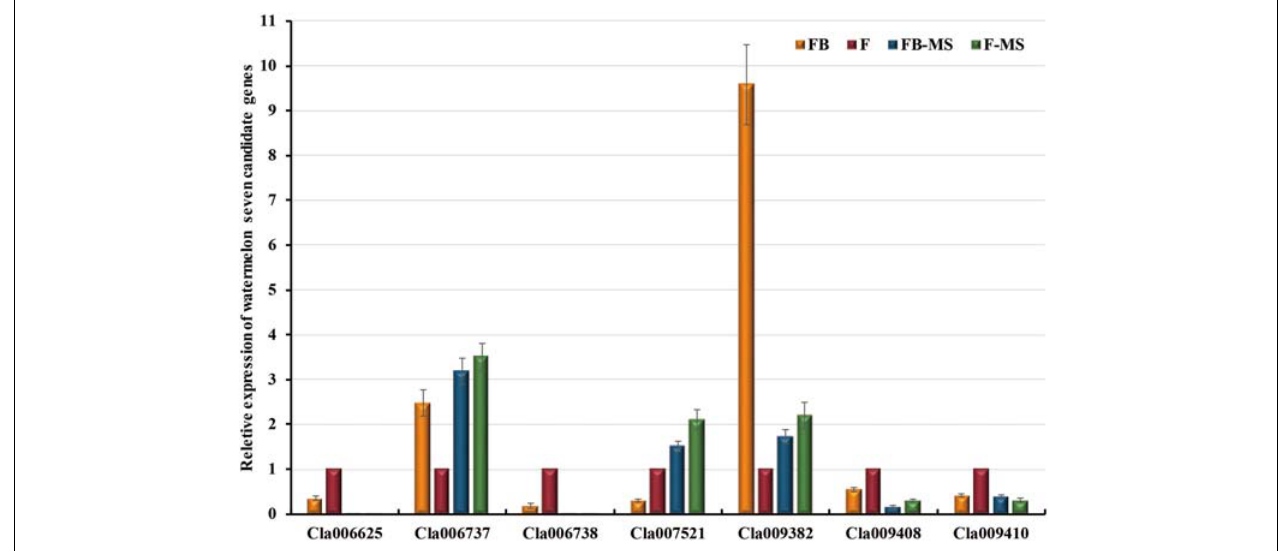
FIGURE 5 | Relative expression levels of seven candidate watermelon genes. The presented data are the average values of six independent measurements. The error bars represent the standard deviation of the mean. FB , flower bud; F , flower; FB-MS , flower bud of male-sterile plants; F-MS , flower of male-sterile